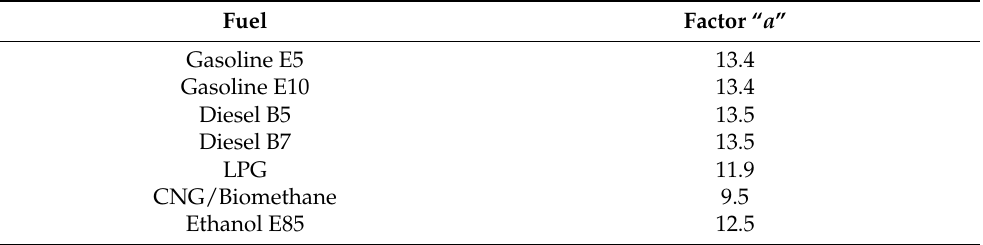
Table 2. Values of the “ a ” factor for specific fuels [1,3].